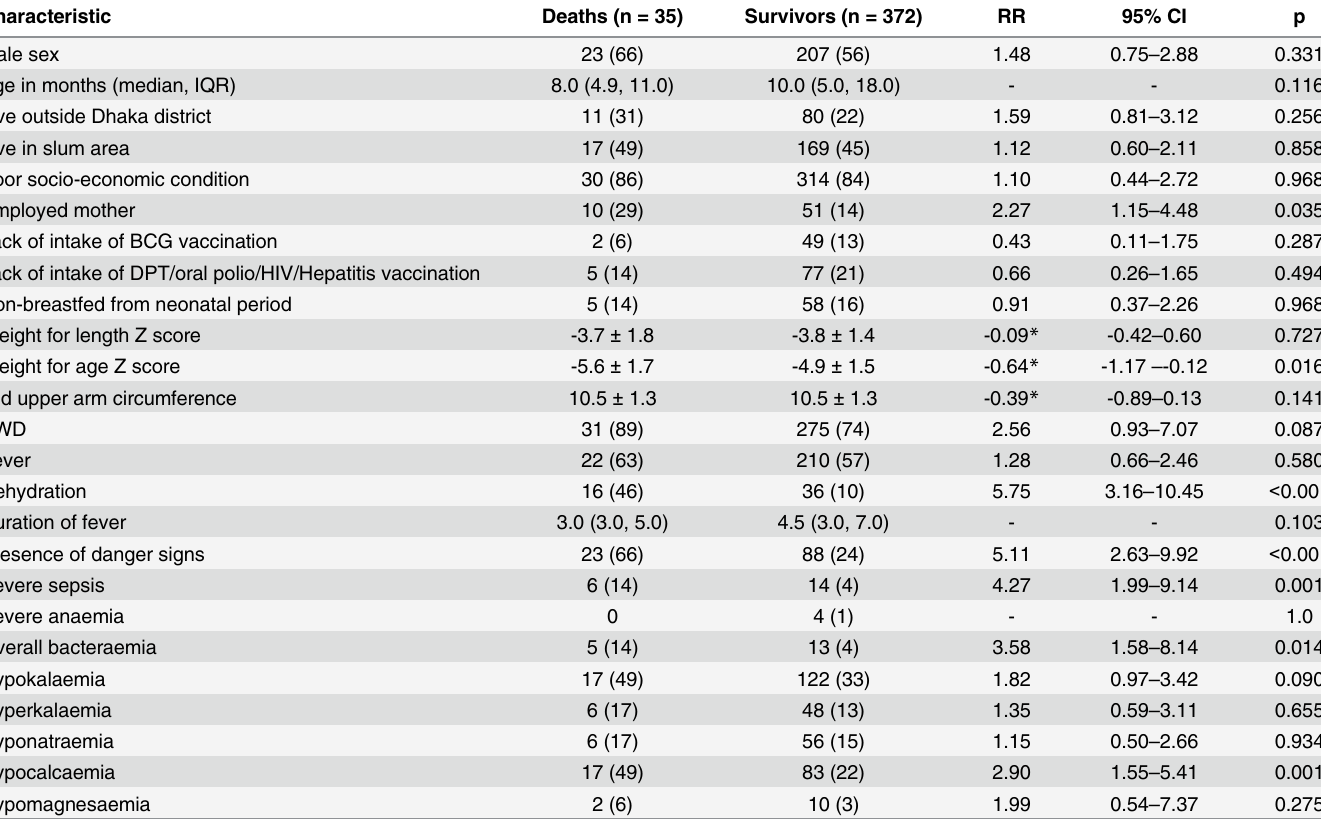
Table 5. Factors present on admission that were associated with deaths during hospitalisation in under-five, severely malnourished children pre- senting with cough or respiratory difficulty and radiological pneumonia.